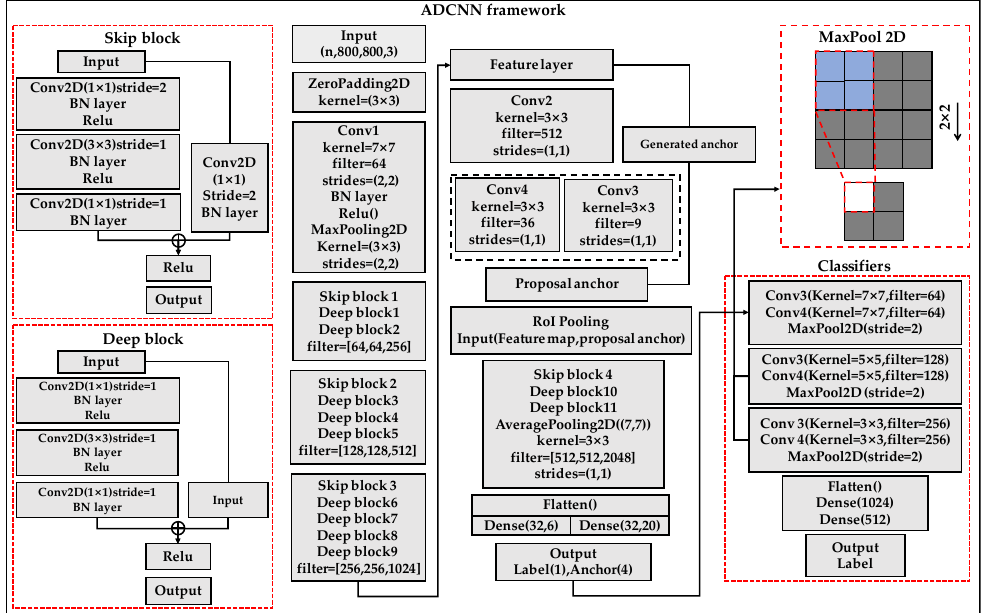
Figure 4. Framework of the ADCNN.